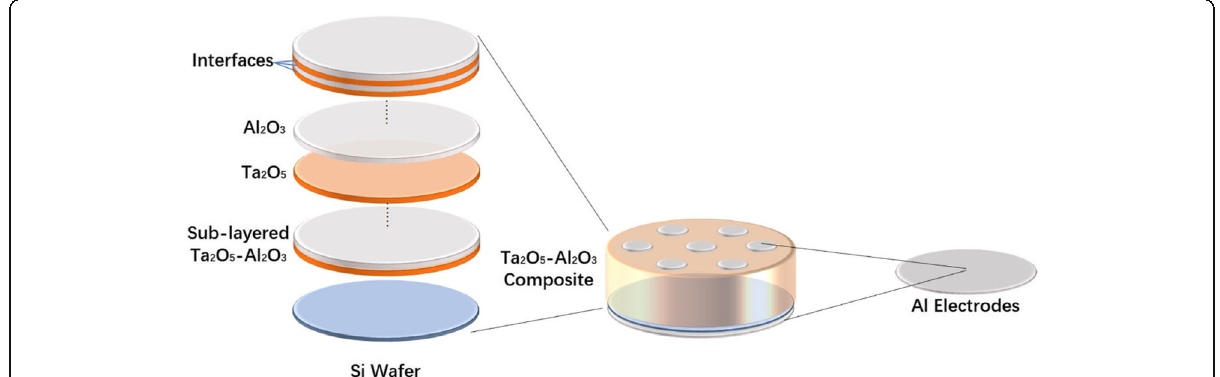
Fig. 2 Schematic diagram for Ta 2 O 5 -Al 2 O 3 composite film and MIS